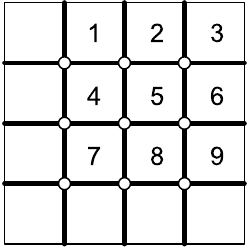
Fig. 5. The plate with cross